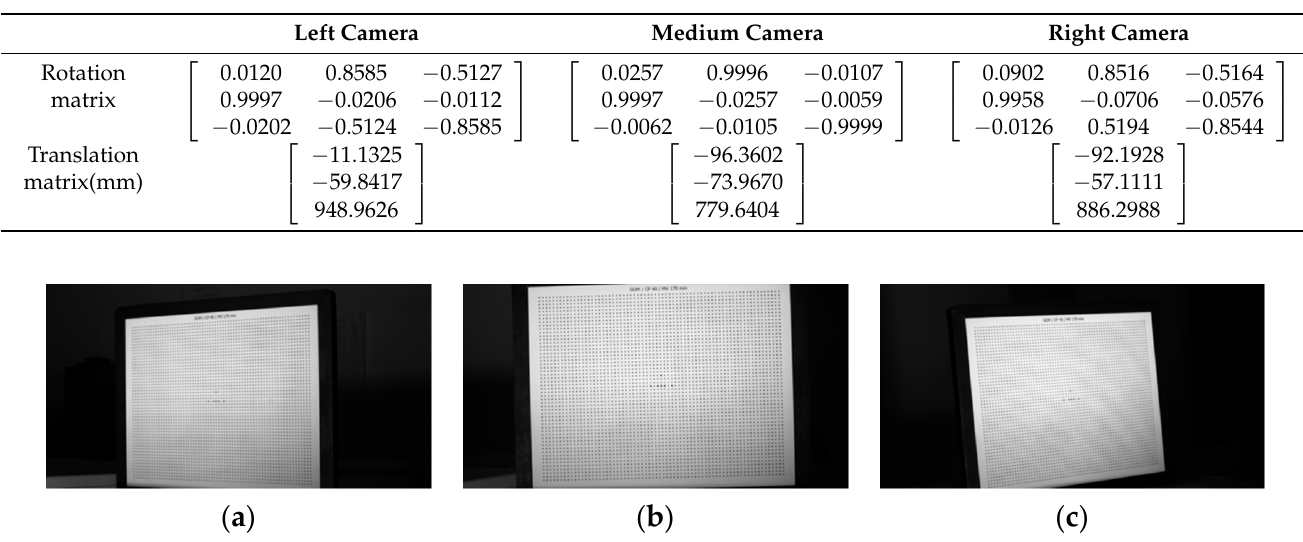
Table 2. Camera calibration exterior parameters.